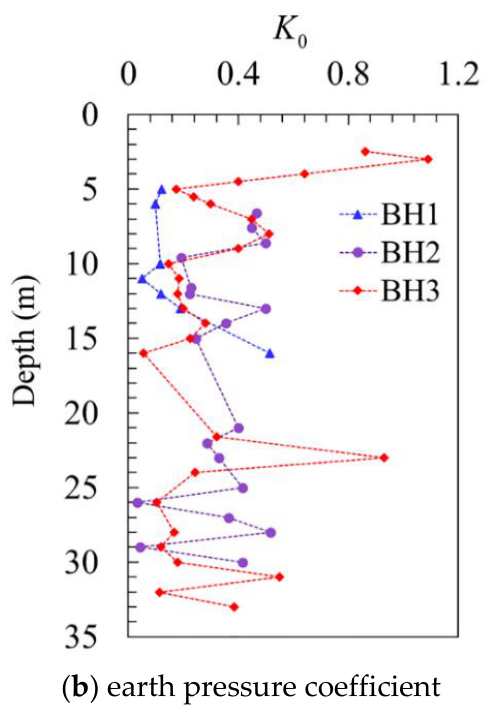
Figure 8. Initial horizontal stress distribution along the depth. By using the horizontal effective stress σ (cid:48) that can be calculated from the value of h0 σ h0 , shown in Figure 8, and the vertical effective stress σ (cid:48) , the coefficient of earth pressure v0 at rest K 0 can be derived as K 0 = σ (cid:48) / σ (cid:48) . As depicted in Figure 8b, K 0 is distributed v0 h0 within the range of 0.03 to 1.21, where for the measuring points near the ground surface of borehole 3, extremely large values are shown, which could be due to the traffic loads of the construction vehicles nearby. In general, the results of the three boreholes are pretty close when the depth is less than 17 m, while, in comparison, the difference of K 0 is relatively larger when the depth is below 17